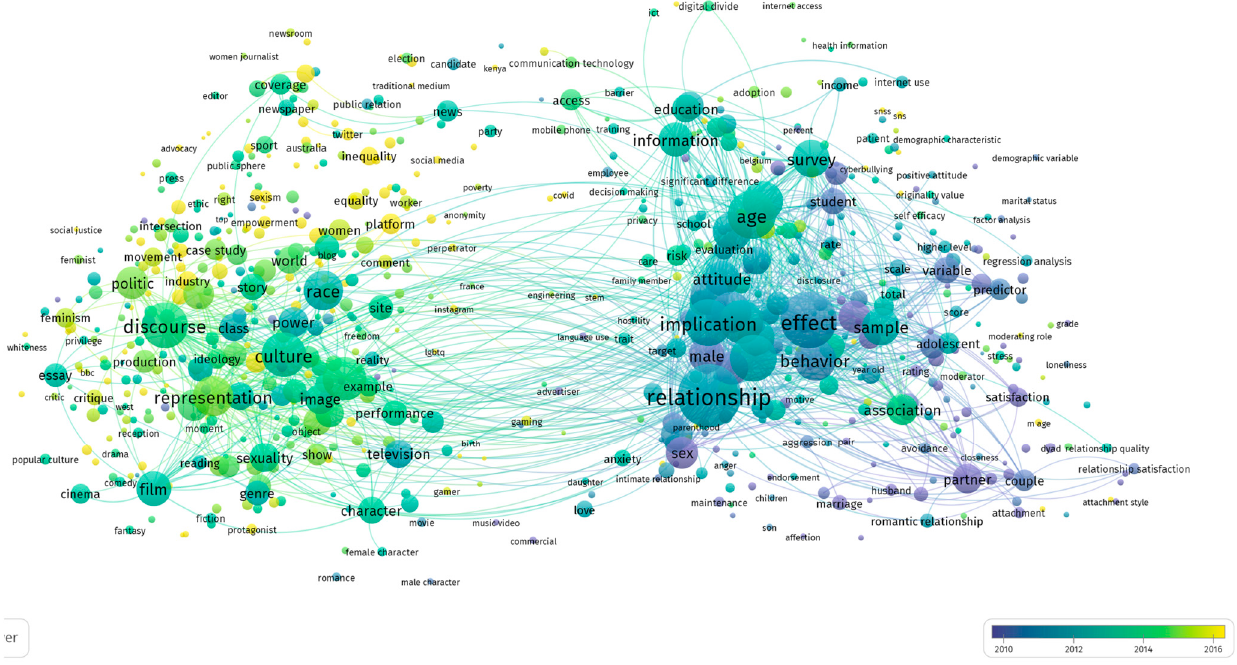
Figure 4. Overlay visualization of term co-occurrence map based on text data with weights based on occurrences.